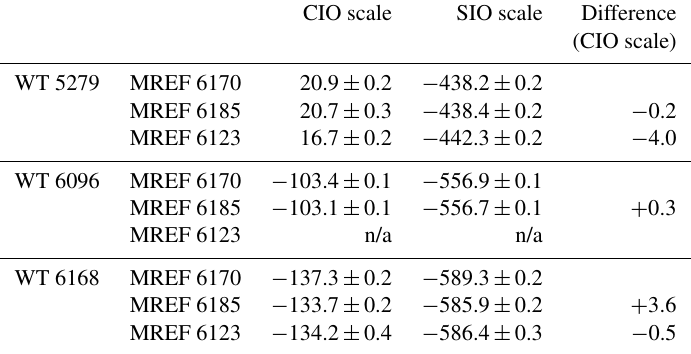
Figure 3. Measurements of the three long-term WTs (5279, 6096, and 6168) for periods 7–15 (Table 1), across the final three MREF periods plus a recently added WT (4845). (a) Raw measurements of the WTs against different MREF cylinders. (b) Measurements of the WTs calibrated and converted to the CIO scale (left y axis) and against the SIO scale (right y axis). The values on the plot are the corresponding long-term means and 1 σ standard errors of the WTs against the SIO scale, and the respective standard deviations are shown in parentheses. All numbers are in per meg. Visible gaps in the data are due to instrument issues, maintenance, or instrument relocation. Table 2. Comparison of the WTs over three different MREF cylinder periods. The values (in per meg) are averaged over the corresponding period, accompanied by the standard errors. The n/a (not applicable) values in the MREF6123 period for WT6096 are due to its discontinu- ation in this period. The difference column values are calculated by subtracting the values of the old MREF periods from the new ones CIO scale SIO